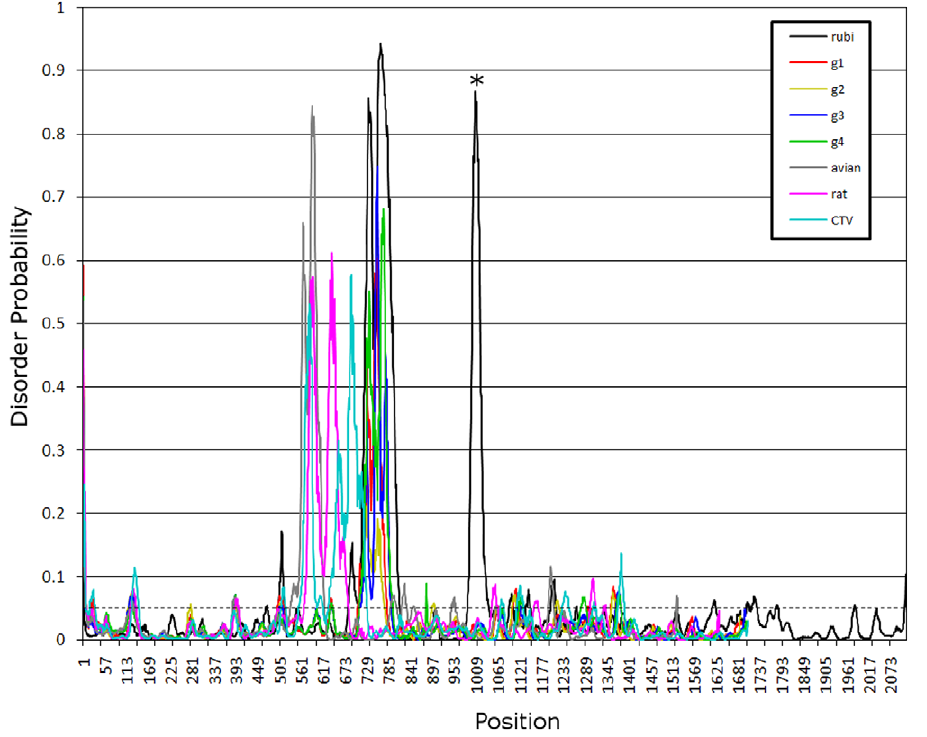
Figure 4. Disorder probability. Disorder probability for aa sequence of selected sequences was calculated using DISOPRED2. A threshold value of 0.05 was set to distinguish between ordered and disordered region along the genome (dashed line). Regions above the threshold are predicted to be disordered (see table 1). All these viruses have a peak above 0.05 within their respective PPRs, positions 570 to 800. Rubivirus has two peaks, one in the PPR and the second at about position 1000, which is just upstream of the endopeptidase (denoted by the asterisk).